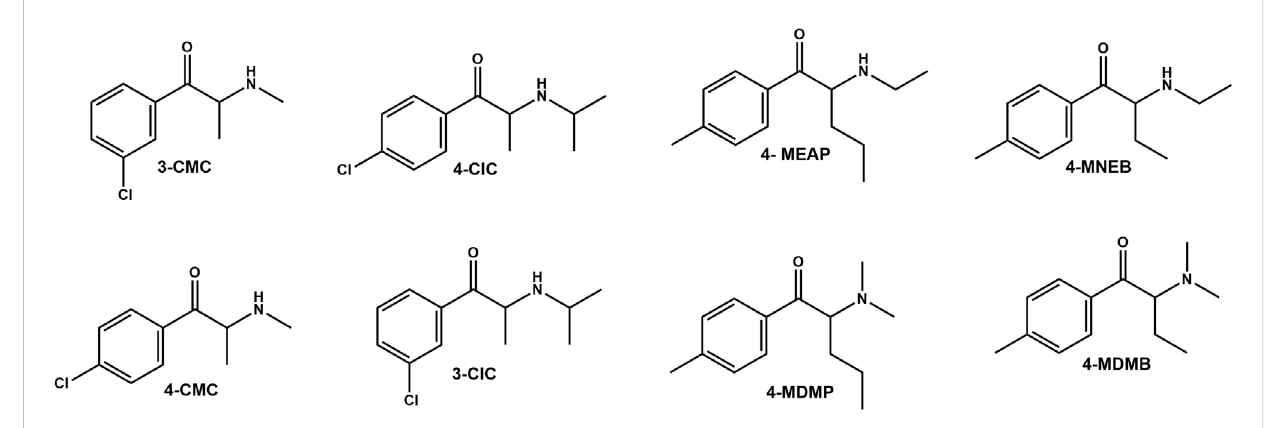
Structures of the cathinones used in the current